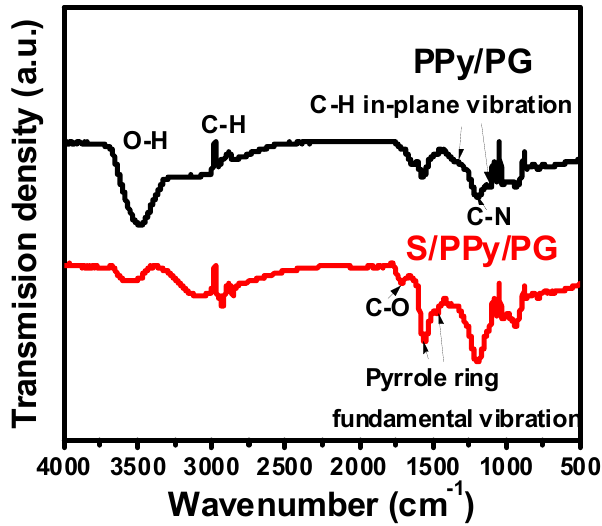
Figure 3. The FTIR spectra of PPy/PG and S/PPy/PG composites.